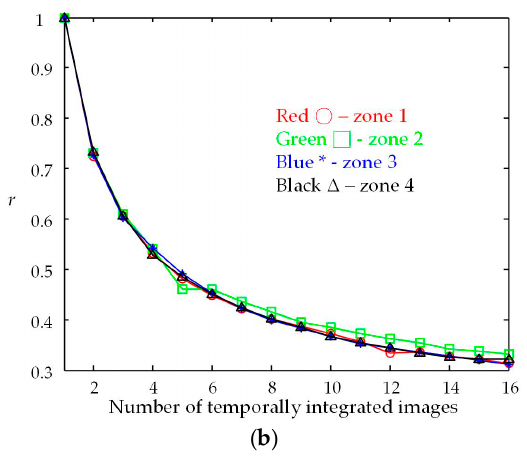
Figure 8. ( a ) Speckle contrast and ( b ) speckle contrast ratio of resultant images using temporal integration of speckled images.